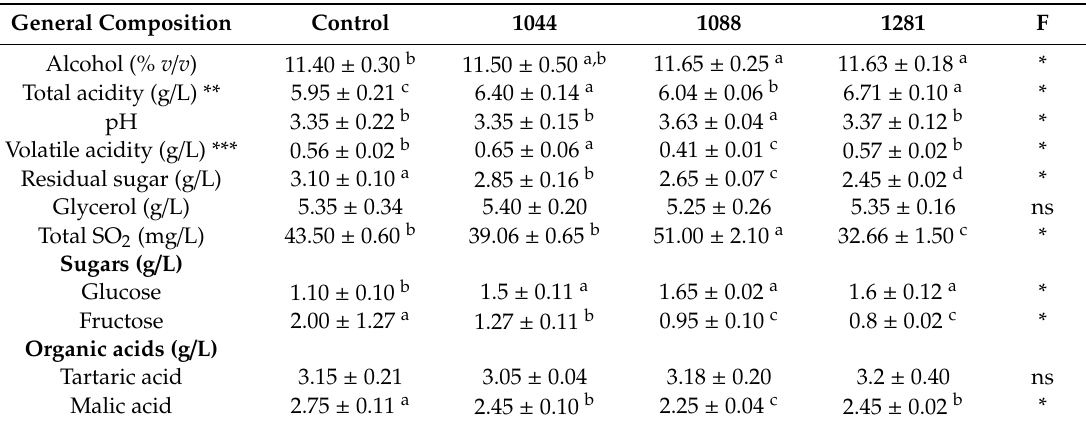
Table 2. General composition of Narince